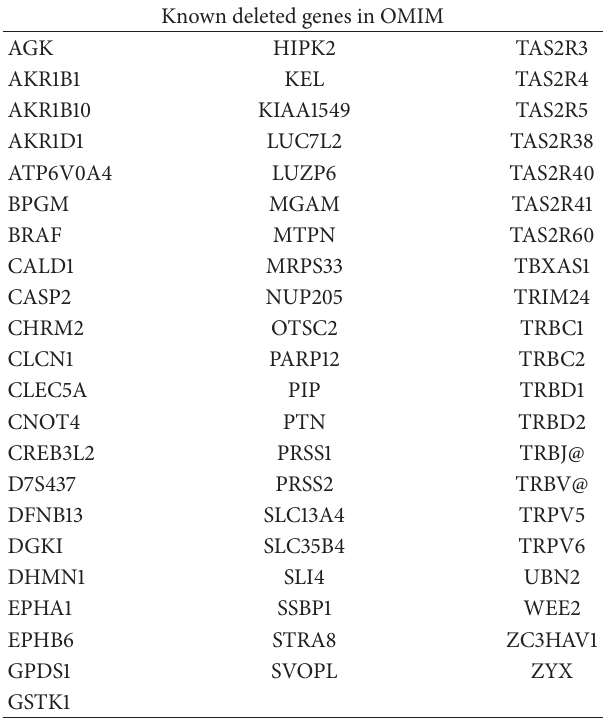
Table 2: Known deleted genes in 7q33-q35 region in